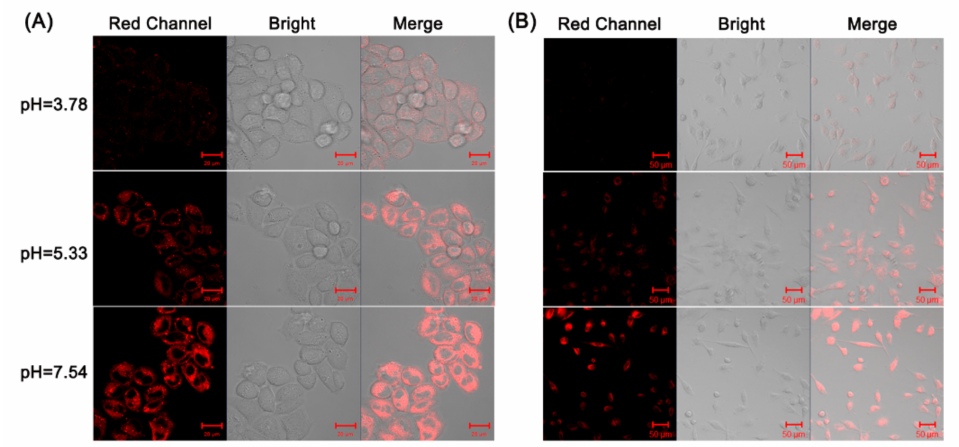
Figure 3. Confocal images of HeLa cells ( A ) and U87 cells ( B ) at different pH levels treated with